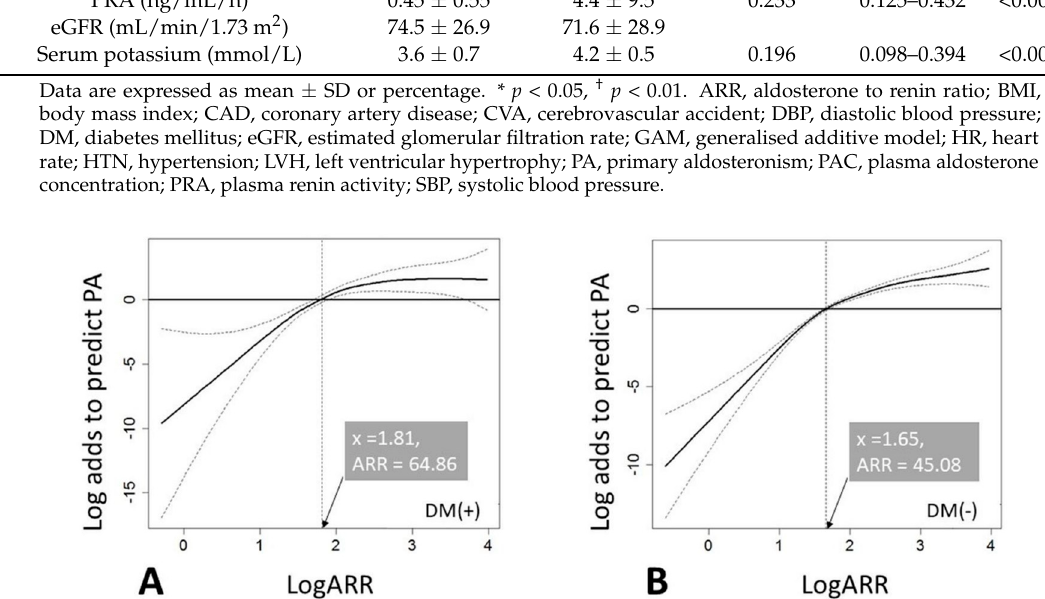
Figure 1. ( A ) GAM plot of screening log of the odds of the probability for PA against the log-transformed ARR in the patients with DM. The cut-off value was ARR = 64.86, (log-transformed ARR = 1.81). ( B ) GAM plot of screening log of the odds of the probability for PA against the log-transformed ARR in the patients without DM. The cut-off value was ARR = 45.08, (log-transformed ARR = 1.65). These models incorporate the subject-specific (longitudinal) random effects, expressed as the logarithm of the odd (logit). The probability of outcome events was constructed with ARR ratio and was centered to have an average of zero over the range of the data as constructed with the GAM. Abbreviations: ARR, aldosterone to renin ratio; DM, diabetes mellitus. GAM, generalised additive model; PA, primary aldosteronism.